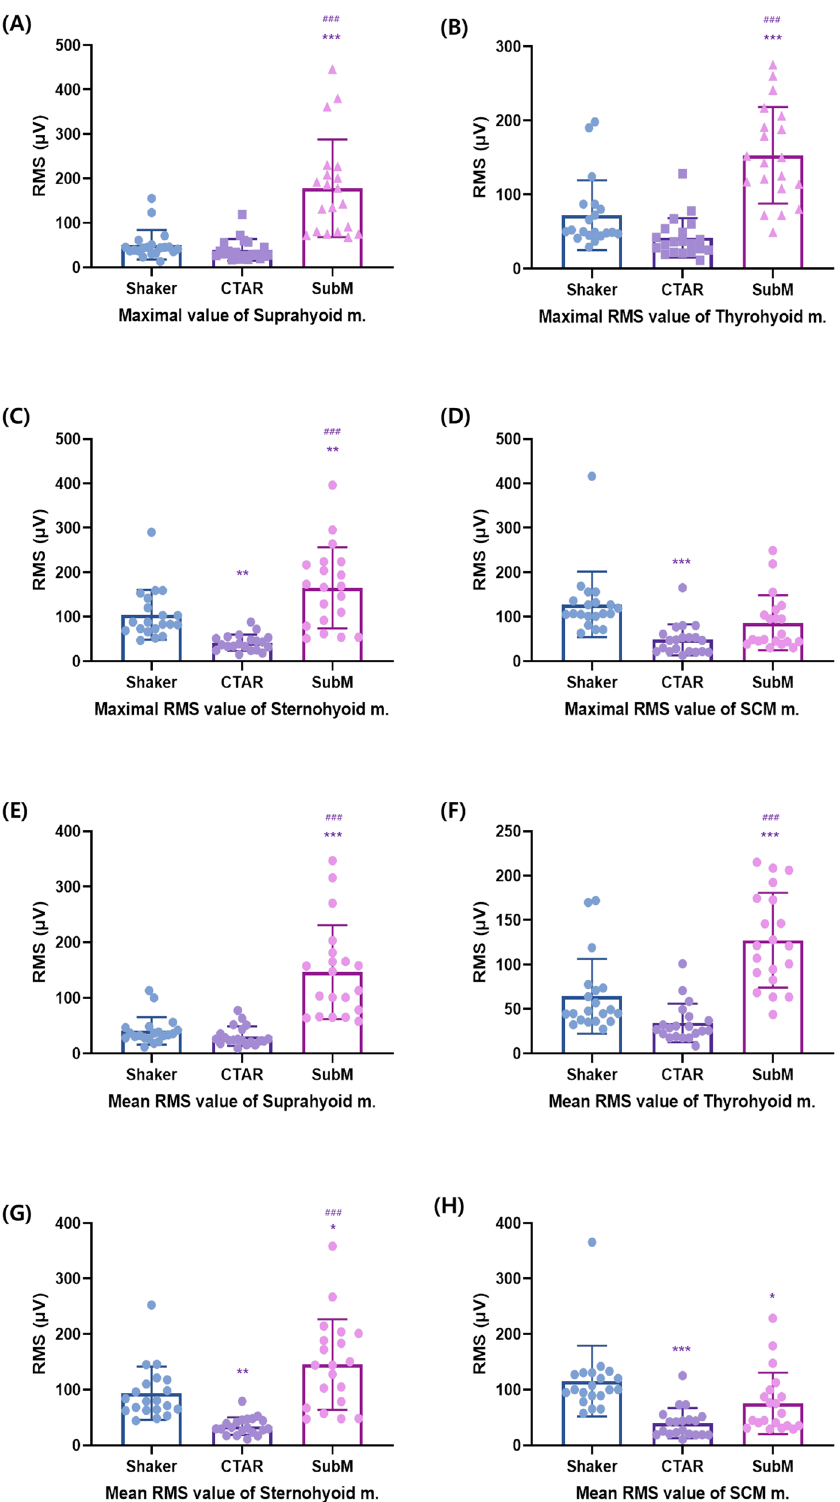
Figure 2. Maximal ( A – D ) and mean ( E – H ) RMS values of the suprahyoid, thyrohyoid, sternohyoid, and SCM muscles in healthy participants. Graphs were drawn using GraphPad Prism software 8.0. RMS, root mean square; SCM, sternocleidomastoid. vs. Shaker; * p < 0.05, ** p < 0.01, *** p < 0.001, vs. CTAR; # p < 0.05, ## p < 0.01, ### p <